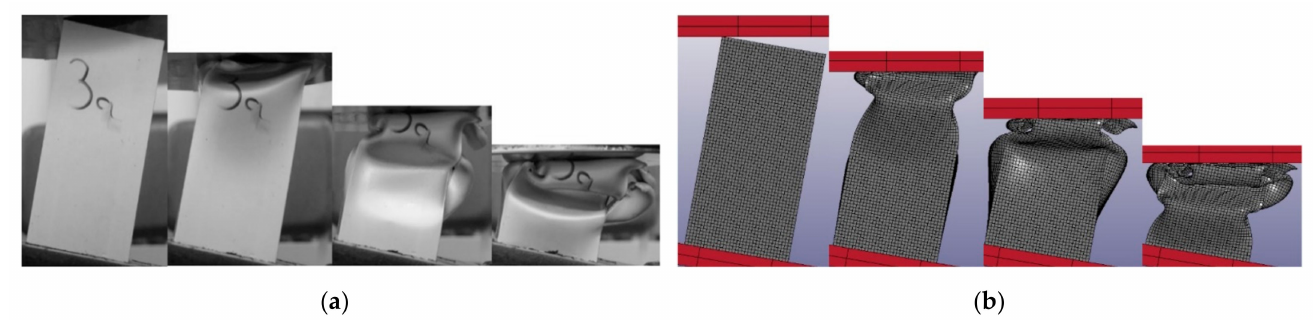
Figure 12. Plastic deformation progress of 10 ◦ crushing angle for edged oblique impact. ( a ) experi- ment; ( b )